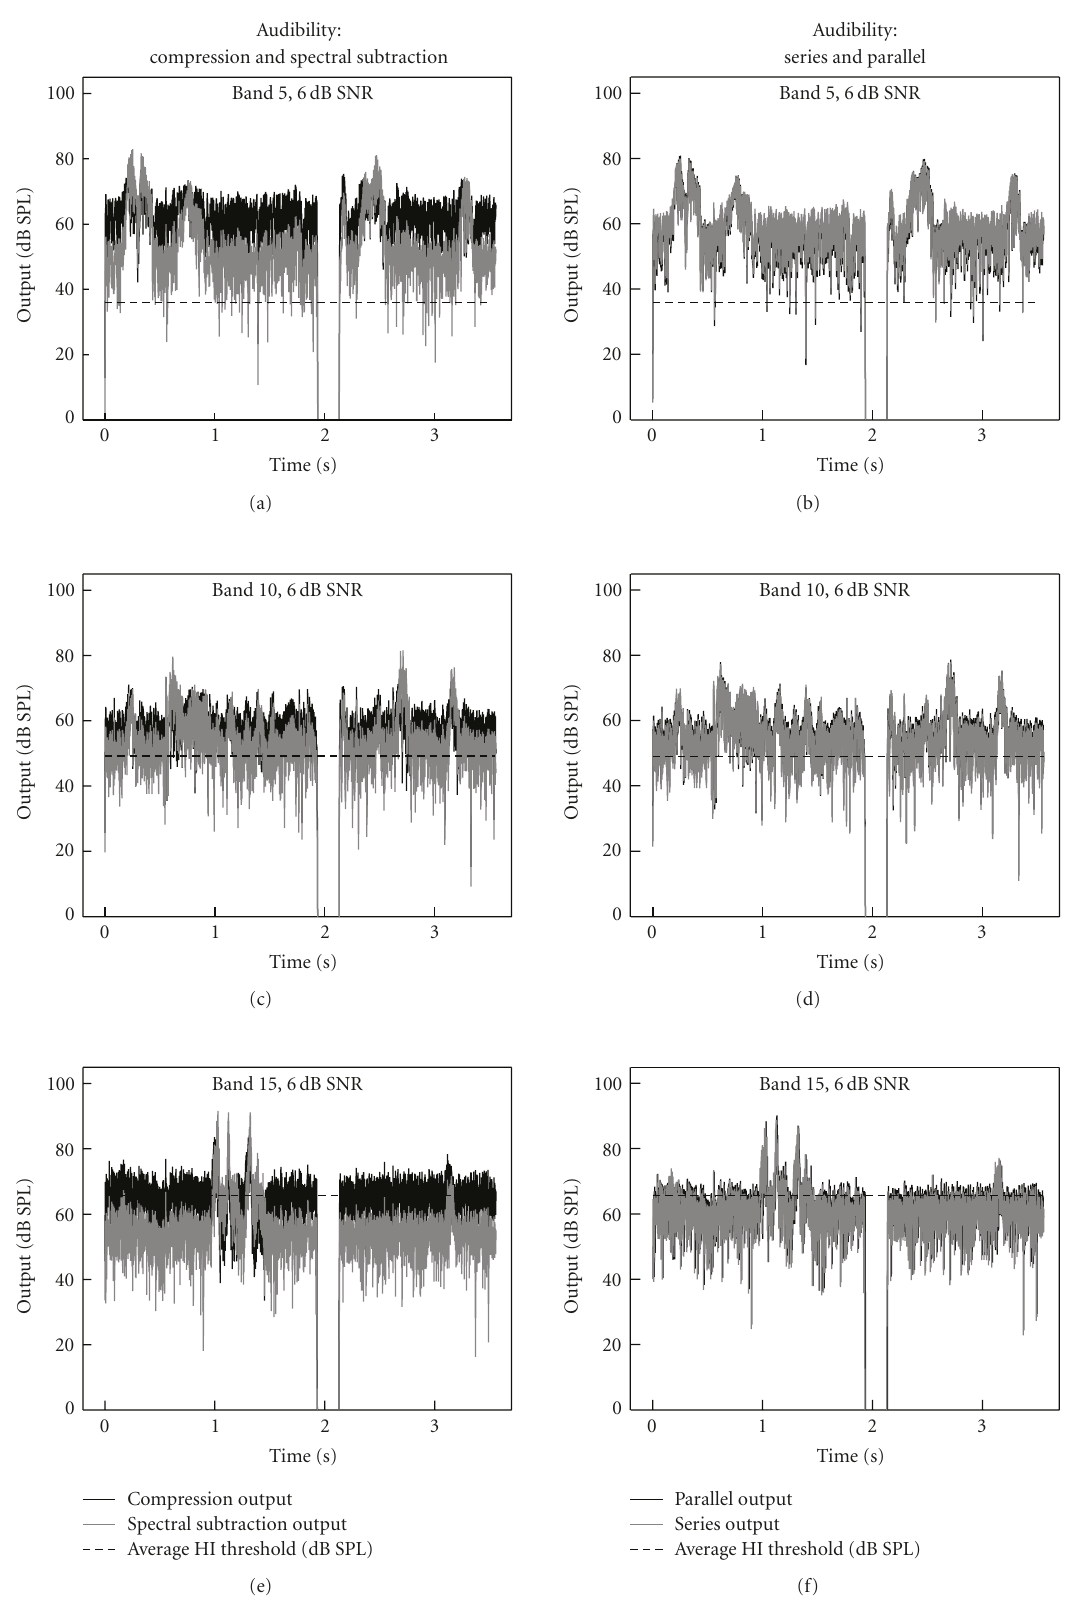
Figure 3: Audibility analysis: the left panels show the level of the signal output at 6dB SNR for compression (black) and spectral subtraction (gray) for bands 5 (cf = 583 Hz), 10 (cf = 1625 Hz), and 15 (cf = 4541 Hz). The right panels show the level of the output signal at 6 dB SNR for parallel processing (black) and series (gray) for the same bands. The average HI threshold (in dB SPL) is indicated by the dashed